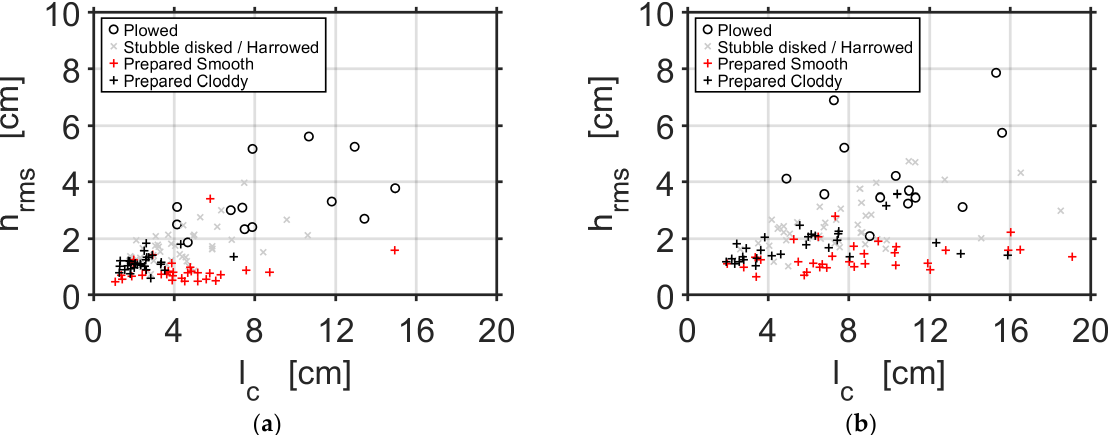
Figure 5. Scatter plot between roughness parameters (root-mean-square height (hrms) and correlation length (lc)) derived from parallel ( a ) and perpendicular ( b ) profiles. Roughness states are grouped into four categories according to soil practices (plowed, stubble-disked, harrowed, prepared cloddy and prepared smooth).